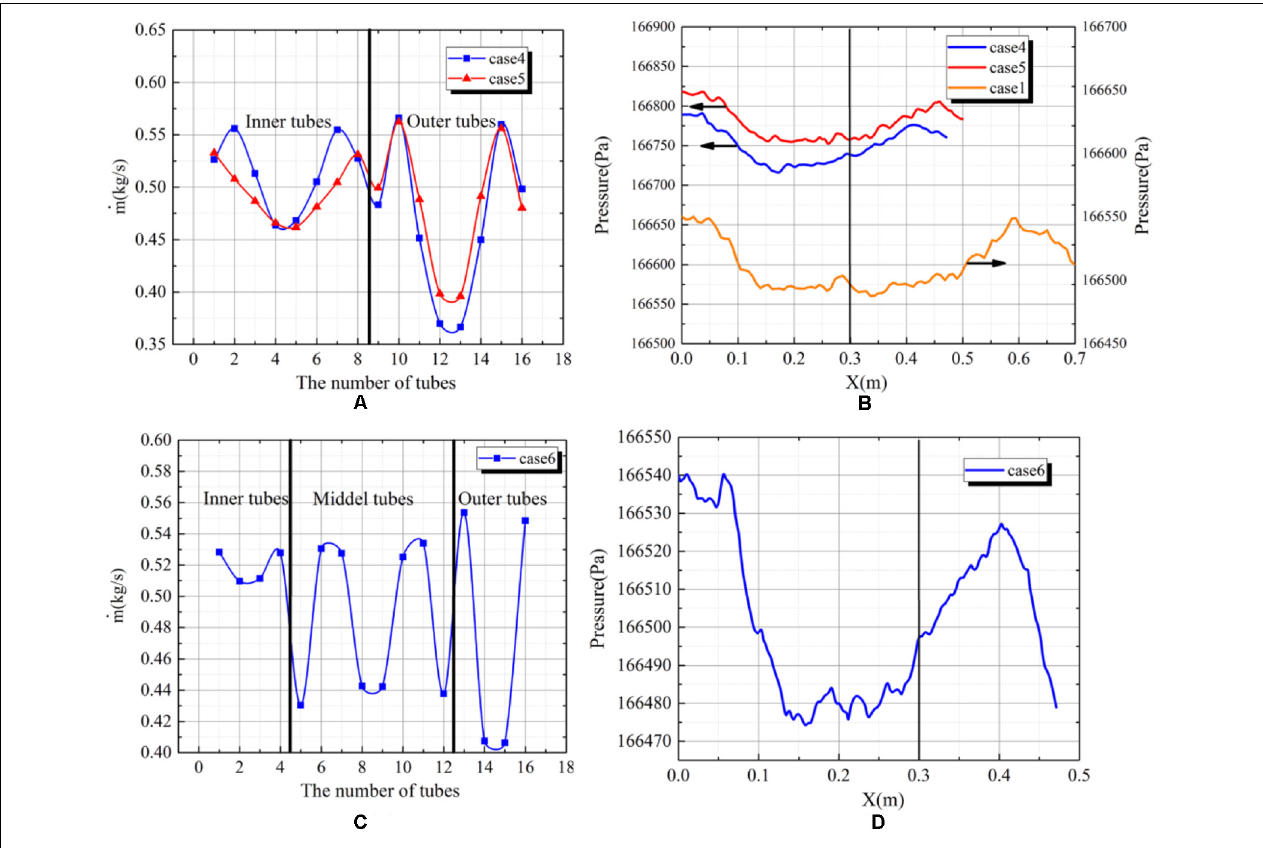
FIGURE 4 | (A) The flow distribution in tubes for case4 and case5. (B) The pressure distribution in the dividing headers for case1, case4 and case5. (C) The flow distribution in tubes for case6. (D) The pressure distribution in the dividing headers for case6.